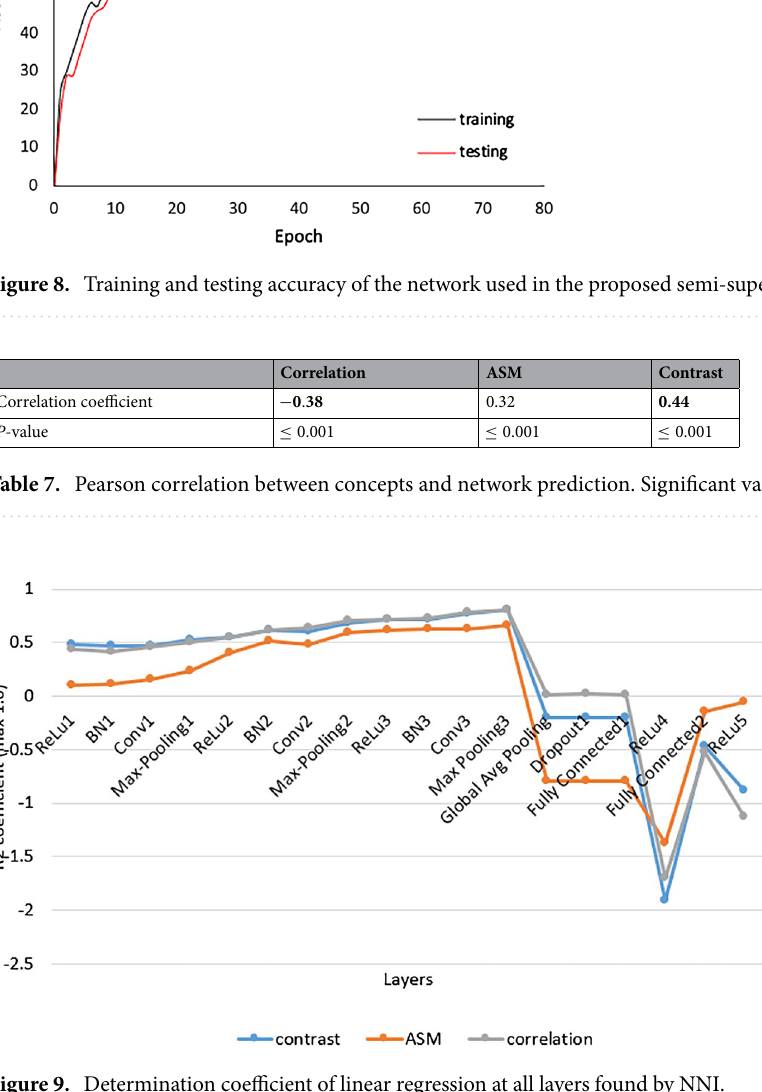
Figure 9. Determination coefficient of linear regression at all layers found by